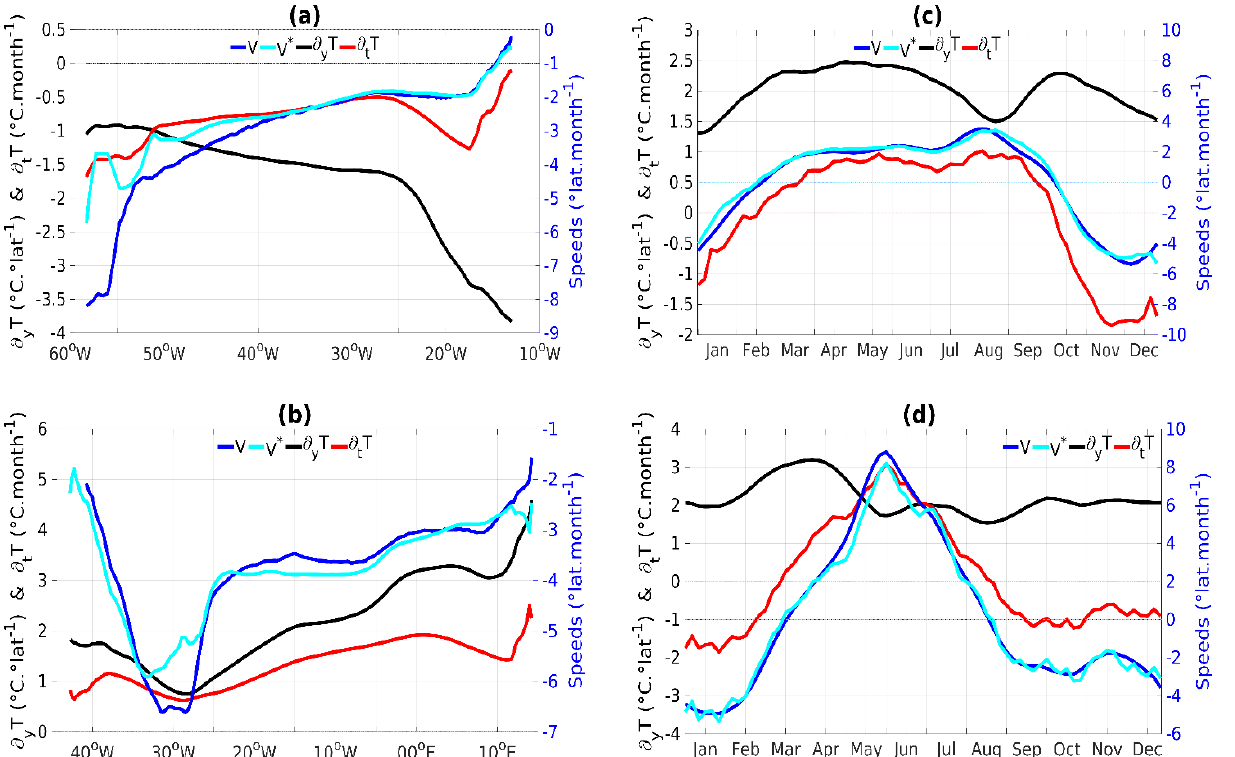
Figure 4. Comparison of V and V* and dependance on dyT and dtT along NB and SB. Zonal structure in time average from December to February (DJF, a , b ) and time evolution in zonal average ( c , d ), exact AWP boundaries migration speed V ( ◦ lat/month, blue), linearized AWP boundaries migration speed V* ( ◦ lat/month, cyan), meridional SST gradient multiplied by ( − 1) ( ◦ C/ ◦ lat, black), and SST time-derivative ( ◦ C/month, red). Along the NB ( a , c ) and the SB ( b , d ).